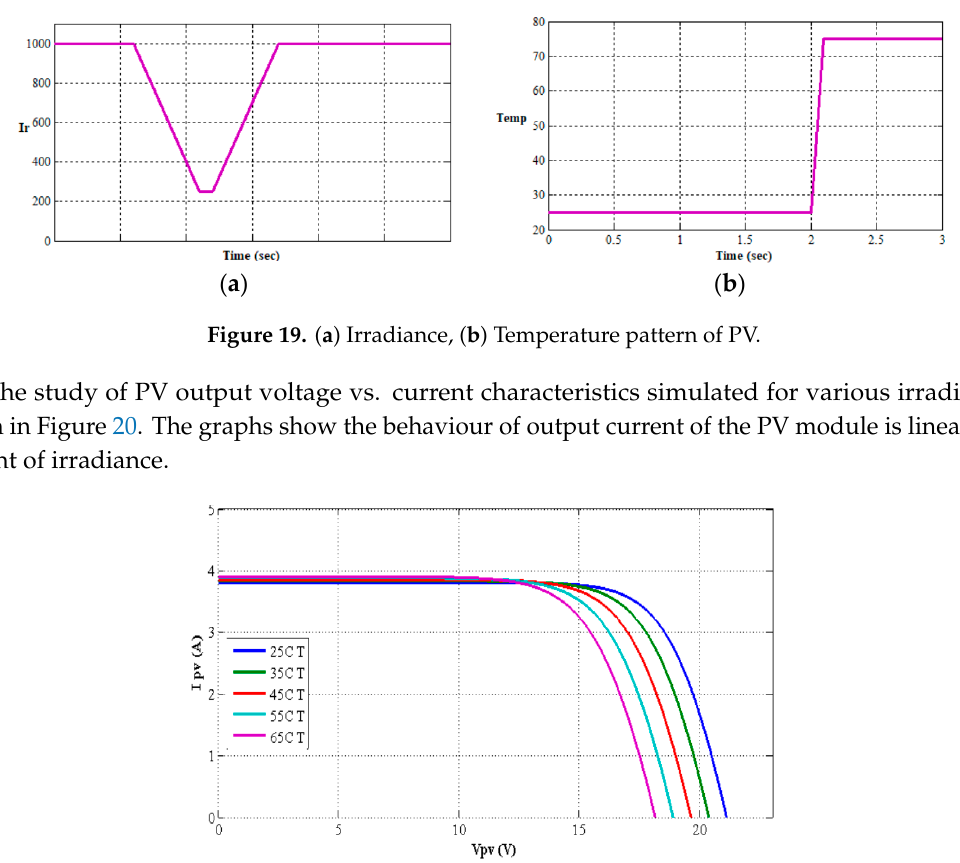
Figure 21. P vs. V Characteristics with varying temperature.